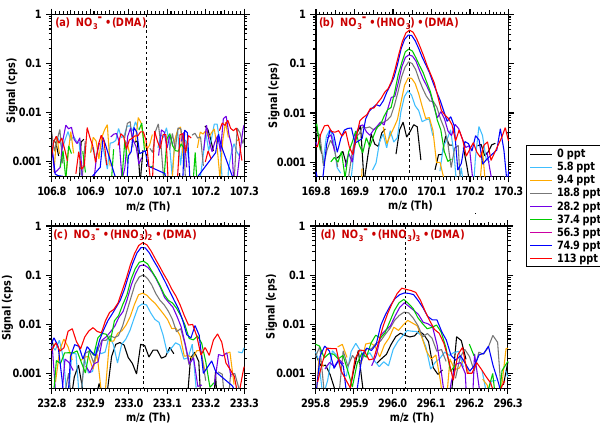
Figure 2. High-resolution mass spectra for narrow ranges of m/z values corresponding to NO − Compared to the DMA ion signals the nitrate primary ion count rates were ∼ 13500cps (for NO − (cid:113) (HNO 3 )) , and ∼ 340cps (for NO − NO − 3 dicate different mixing ratios that were established in the CLOUD chamber during calibration measurements and the dashed vertical lines show the exact mass of the cluster